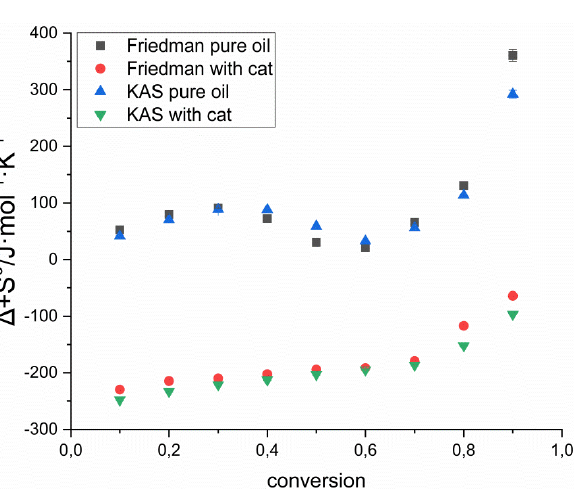
Figure 7. Dependency of the activation enthalpy vs. conversion for catalytic and non-catalytic peat pyrolysis.